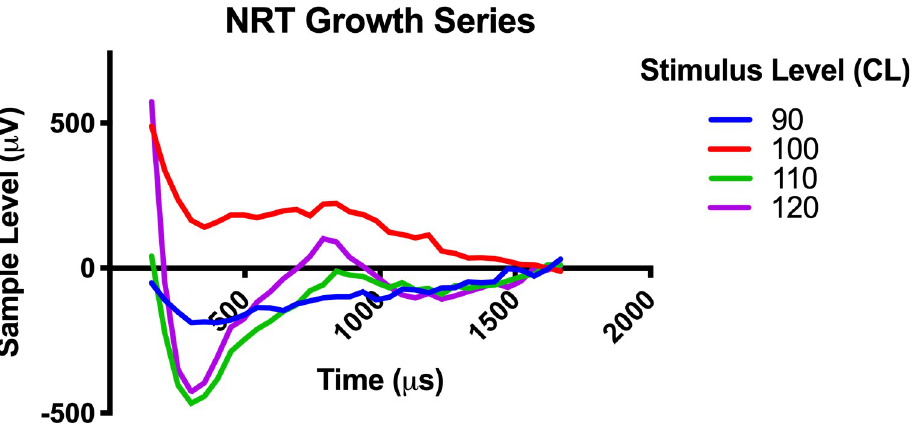
Fig 7. Neural response telemetry (NRT) growth series. Individual NRT responses in response to an escalating stimulus level between 90 and 120 CL is presented as an example of a typical NRT growth series.